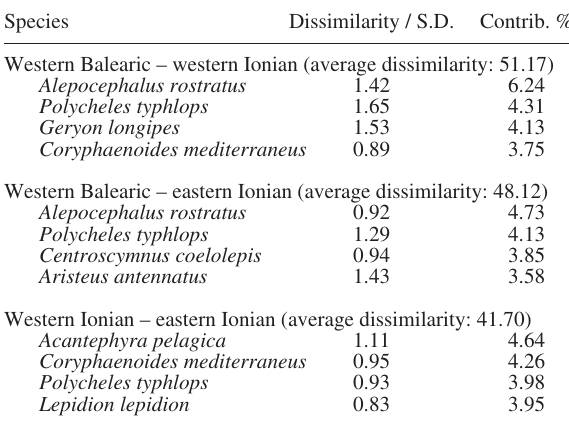
Table 3. – Dissimilarities between the three geographic zones as calculated by the SIMPER statistical